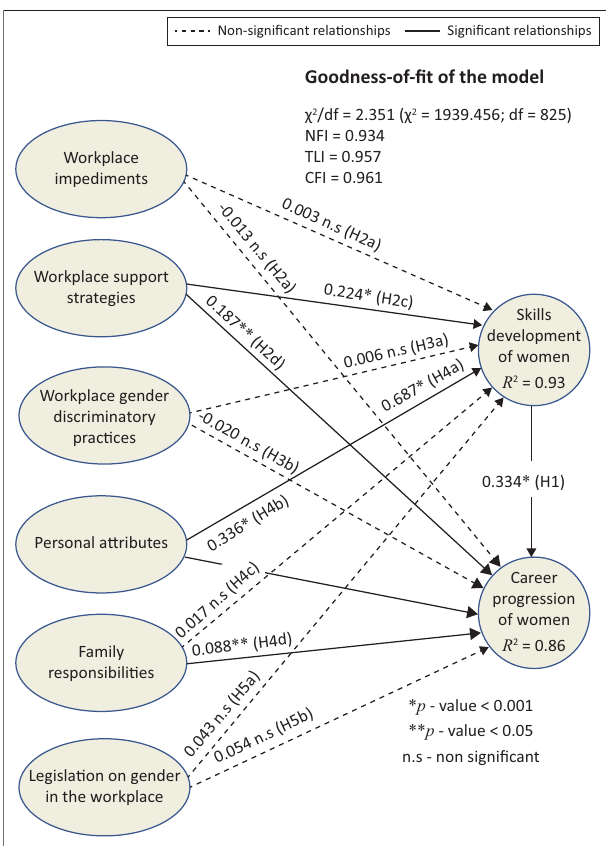
FIGURE 1: Results for factors affecting women’s skills development and career